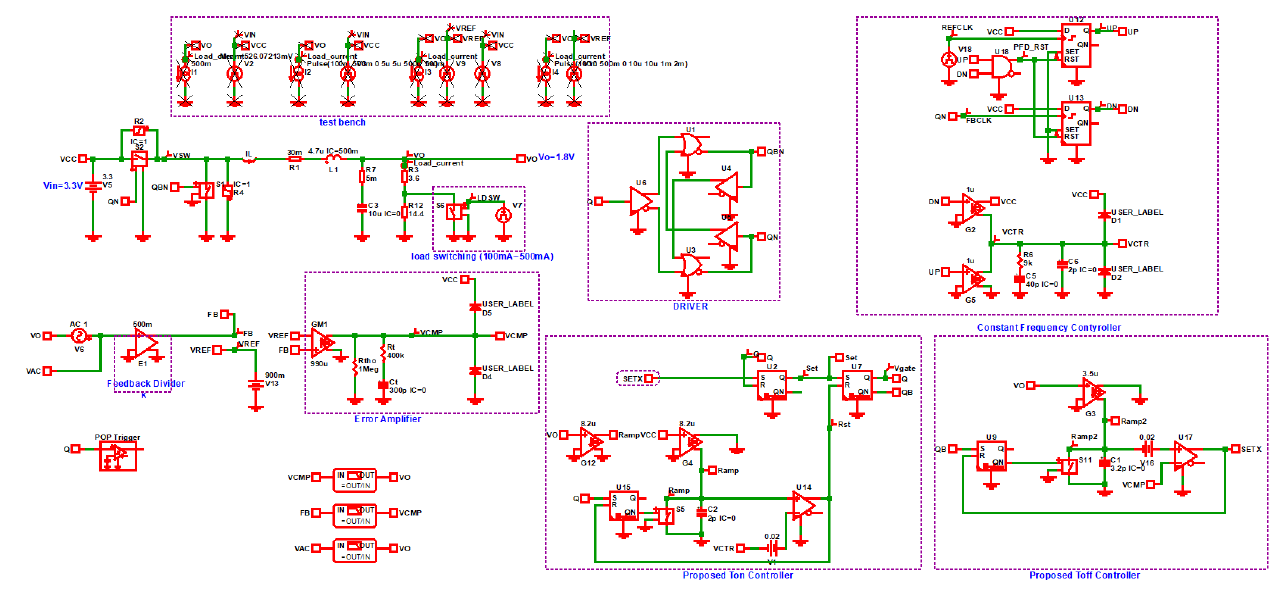
Figure 8. SIMPLIS schematic for the proposed converter.